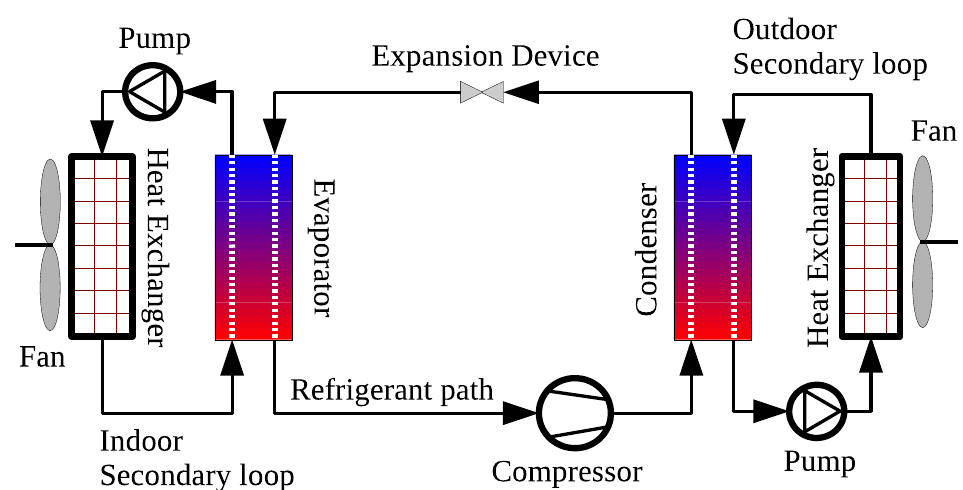
Figure 22. Schematic for a typical vapor compression system with secondary heating and cooling loops.